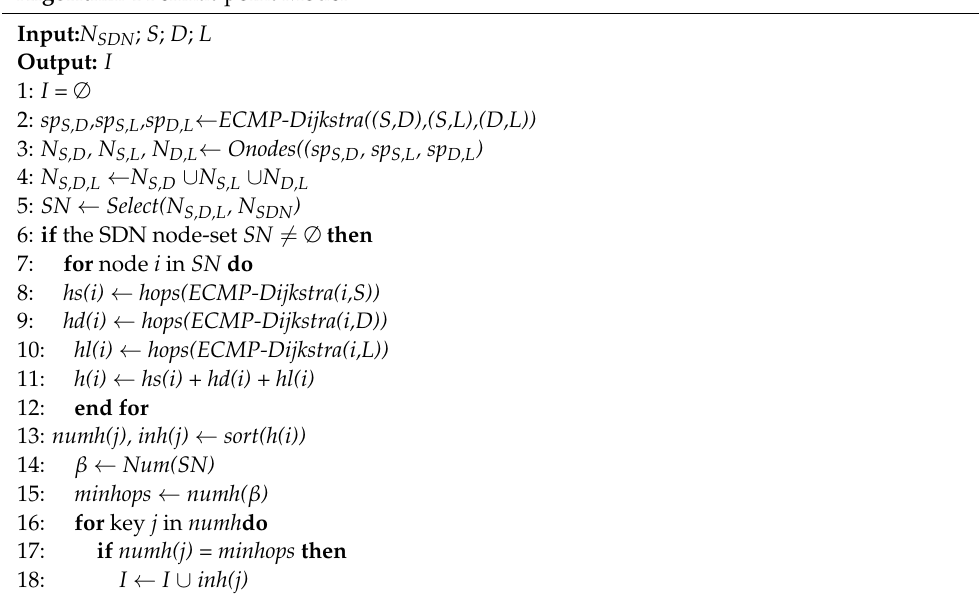
Algorithm 4 Fermat-point